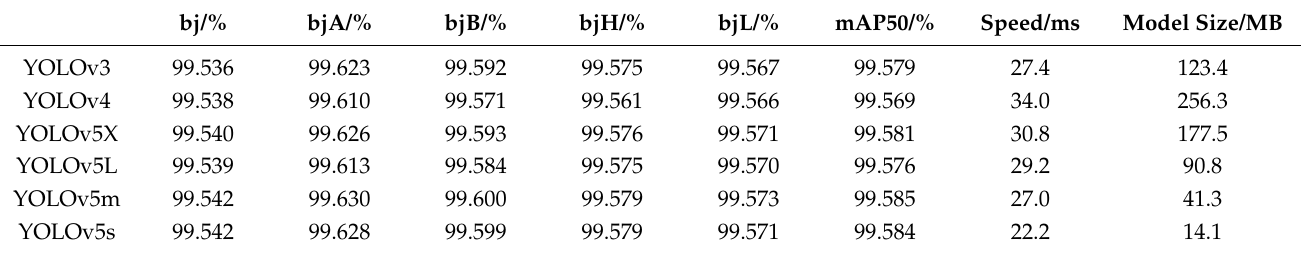
Table 3. The comparison of meter detection model results.